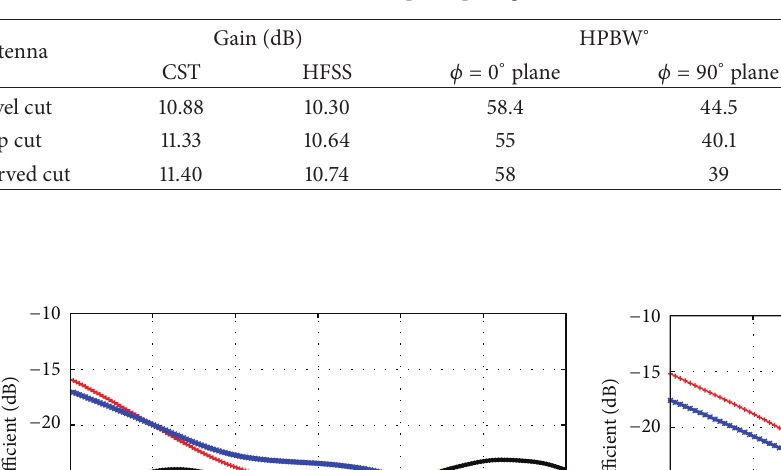
Table 2: Compared peak gain, HPBW, and sidelobe level ratio (SLR).